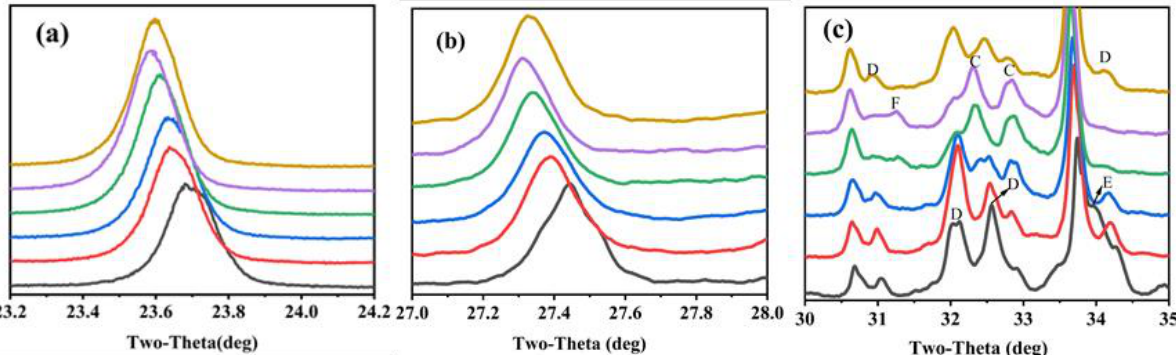
Figure 3. Zoomed section of characteristic peaks migrate with variation proportion of CaSO 4 as a CaO source ( a ) ye’elimite at about 23.7 ◦ , ( b ) ye’elimite at about 27.4 ◦ and ( c ) belite-al’(C), belite-beta (D), brownmillerite (E) and anhydrate (F).